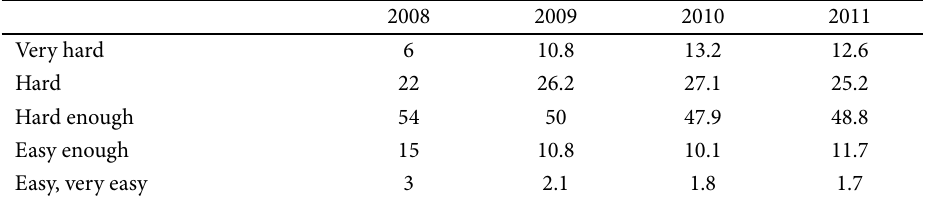
Table 4. Distribution of households in Lithuania in accordance with a household’s ability to make ends meet, %